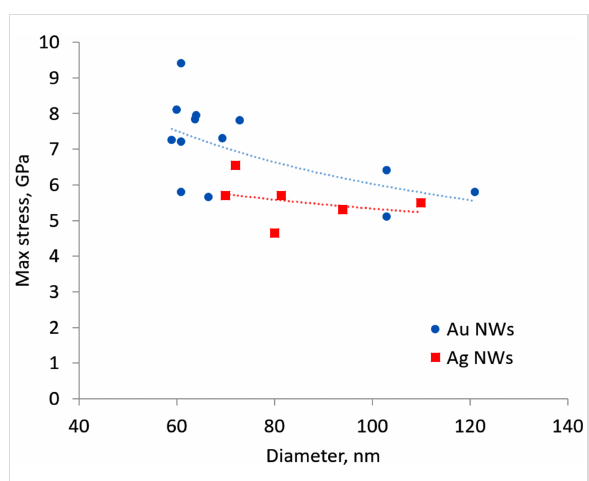
Figure 7: Au and Ag NW yield strengths as revealed from the bending tests.